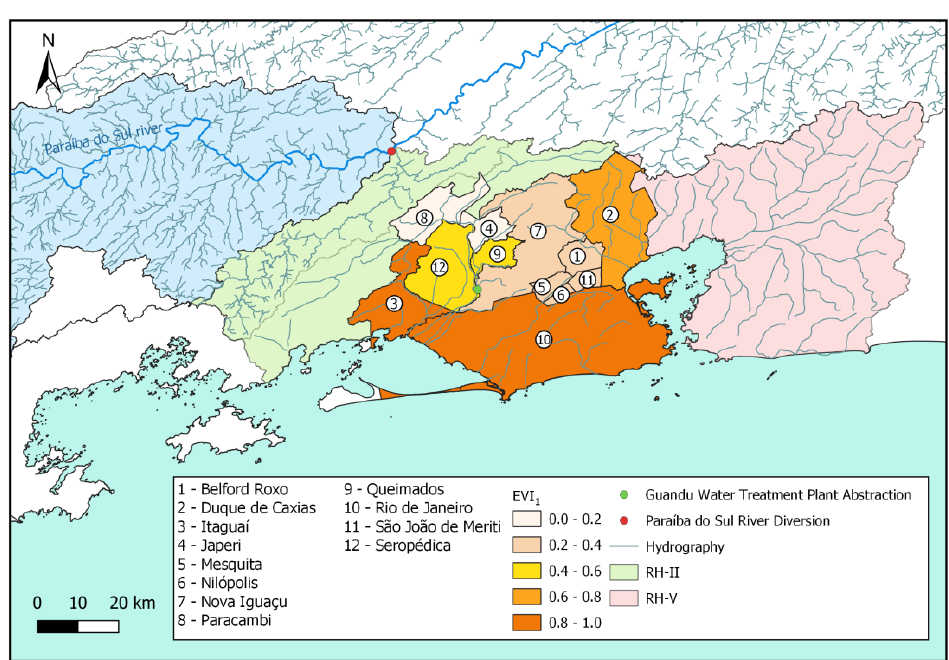
Figure 12. Economic vulnerability indicator ( EVI 1 ) application for each municipality supplied by the Guandu/Lajes/Acari system.